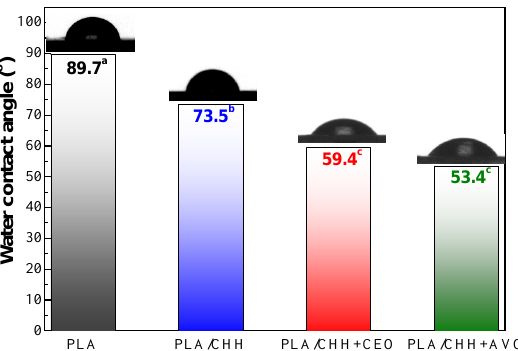
Figure 5. Water contact angle of PLA film with oil-loaded chitosan coatings. The data are ex- pressed as mean ± standard deviations from triplicate determinations. a – d Mean values with differ- ent letters indicate significant differences at p < 0.05.